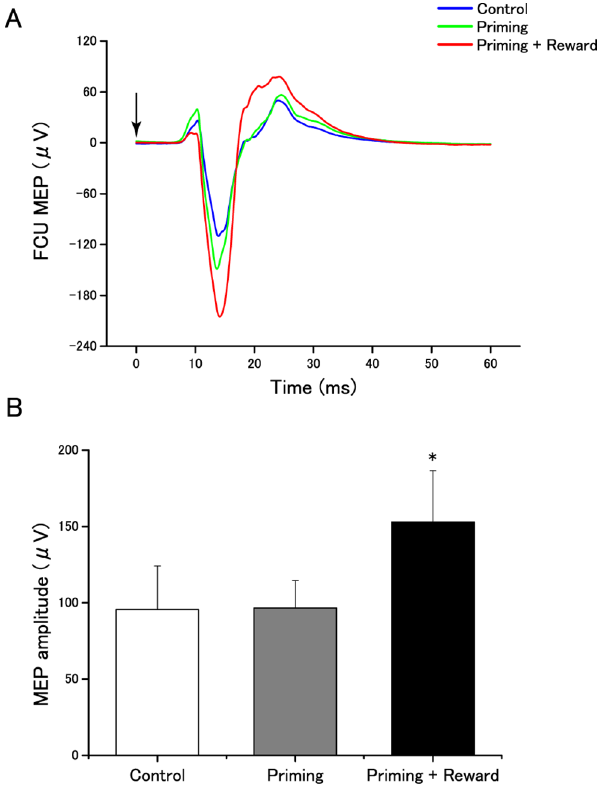
Figure 3. Effects of barely conscious goal pursuit on MEP amplitude. A: Typical recordings of the average MEP of all 50 trials for FCU during three experimental conditions in a singleparticipant. Arrows indicate the timing of TMS. B: Amplitudes of MEPs for the three experimental conditions. Data are expressed as mean 6 SEM. Asterisks indicate statistically -significant differences compared with other conditions (* p , 0.01).